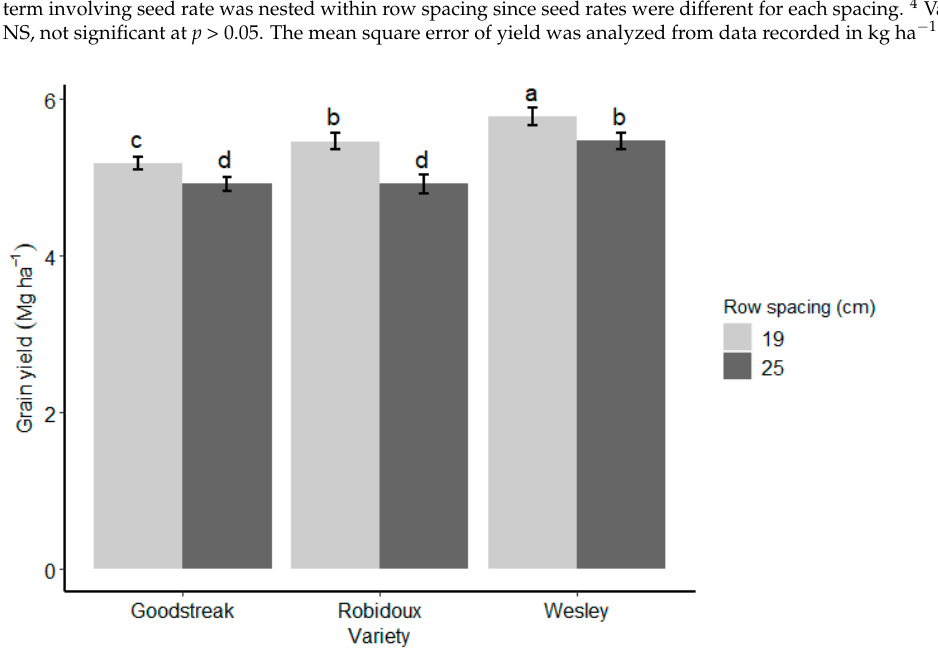
Figure 2. Winter wheat grain yield as affected by the interaction between planting date and variety at Hemingford and McCook experimental sites. The error bars represent the standard error of the